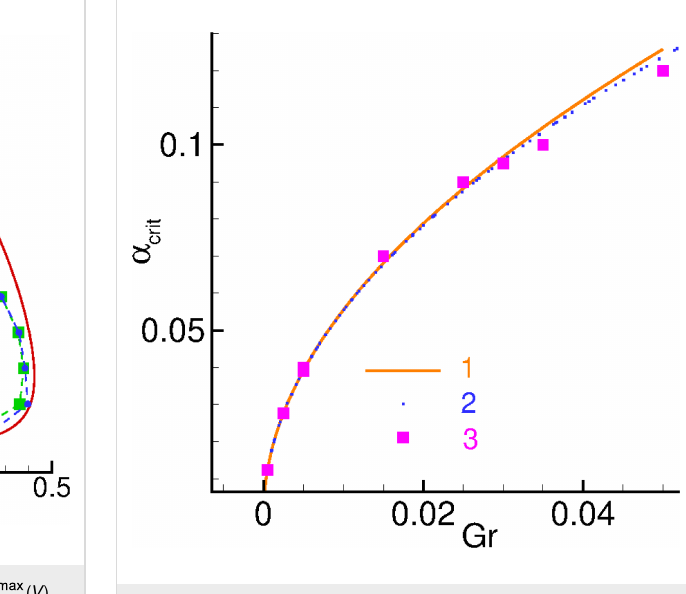
Figure 11: Numerical calculations according to Equation 6 (squares), analytical calculations according to Equation 23 (solid line), and ap- proximated analytical calculations according to Equation 24 (dashed line). Table 1: A comparison between the numerical and analytical values of α crit at different values of G and r